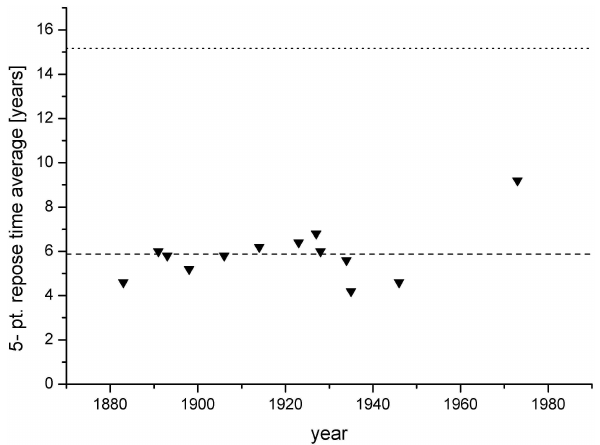
Fig. 4. Stationarity check for Nevados de Chill´an (eruption record after 1860). The 5-point moving averages of the repose times are distributed around their mean value (dashed line) and with variation that can be explained by stochastic effects (below the dotted line corresponding to two standard deviations distance from the